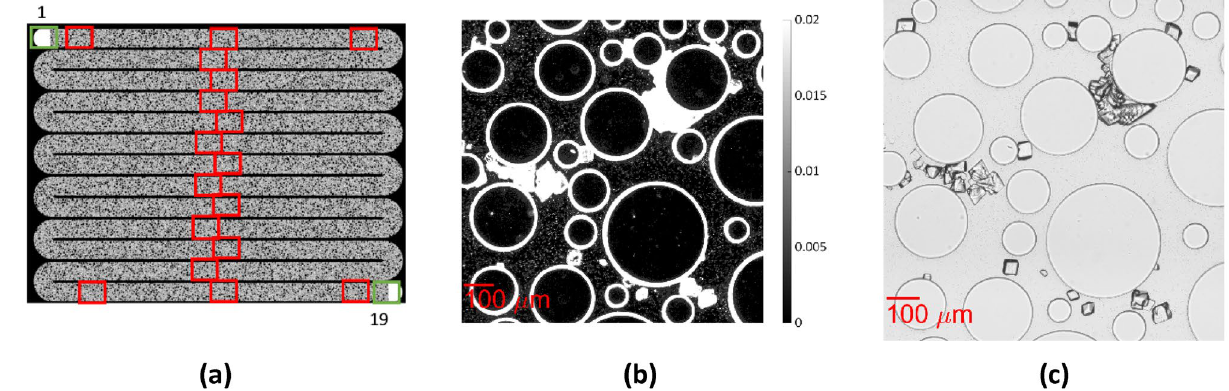
Figure 2. ( a ) Sampled positions; ( b ) Section of dimensions 1.022 mm × 1.022 mm of the green channel of the original image captured with phase-contrast microscopy and ( c ) of the green channel of the original image captured with phase-contrast microscopy.